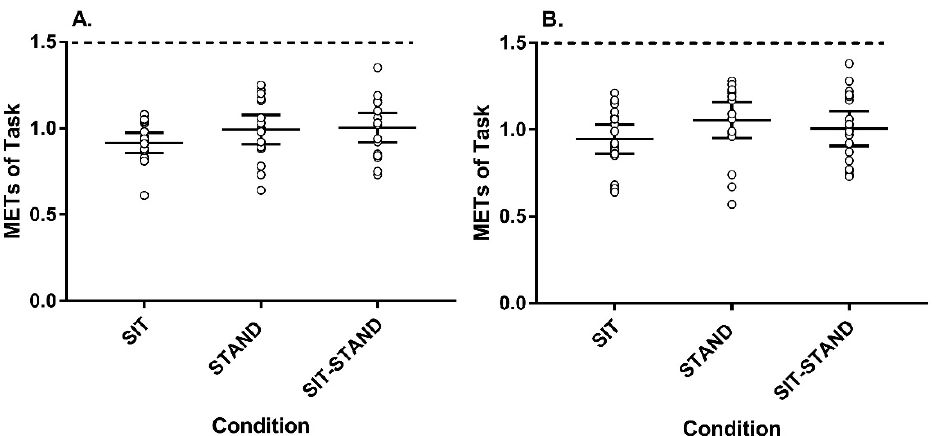
Figure 1. Intensity (METs) of typing ( A ) or writing ( B ) by condition. Horizontal lines indicate the condition mean and 95% CI, the dashed line represents the light intensity threshold. A (mean ± SD METs): SIT: 0.92 ± 0.16, STAND: 0.99 ± 0.20, SIT-STAND: 1.00 ± 0.24. B (mean ± SD METs): SIT: 0.95 ± 0.23, STAND: 1.06 ± 0.24, SIT-STAND: 1.01 ± 0.26. SIT: 60-min sitting condition, STAND: 60-min standing condition, SIT-STAND: 30 min of standing followed by 30 min of sitting condition.